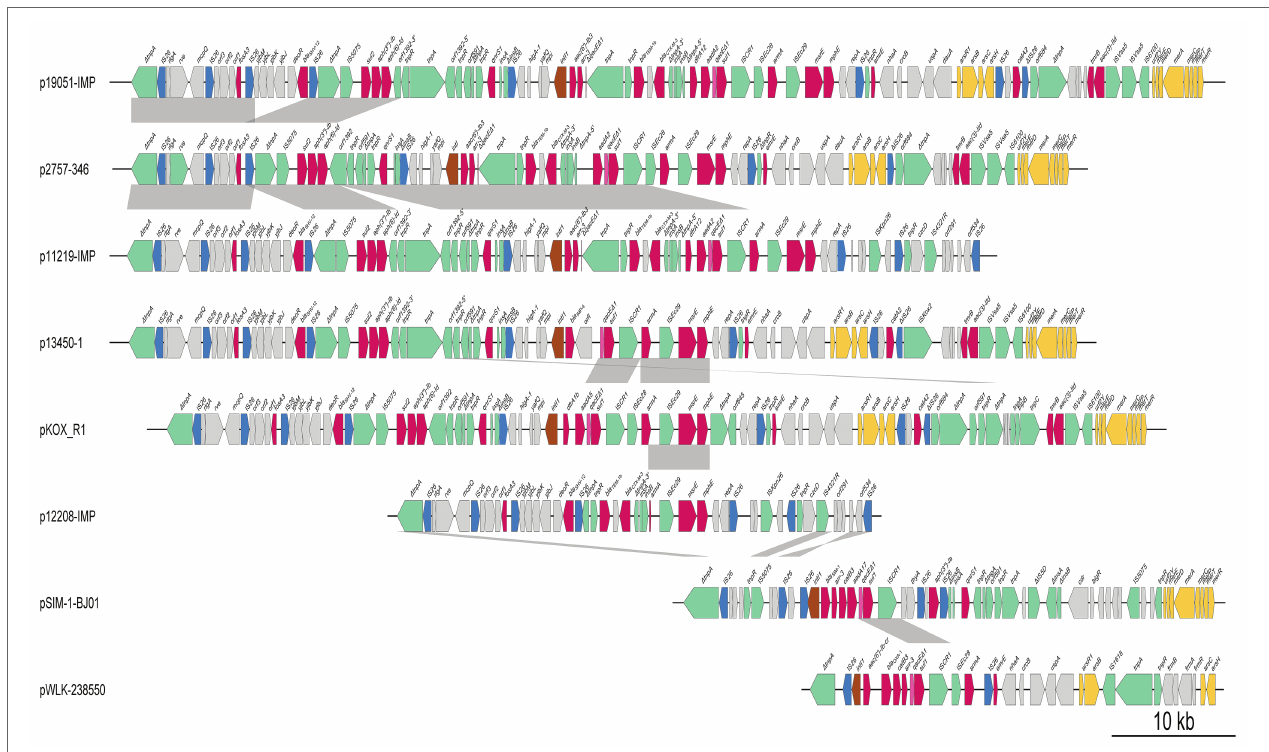
FIGURE 5 | Comparative genomic analysis of antibiotic resistance island B (ARI-B). Mobile elements are shown by green, brown, and blue arrows, respectively. The red arrows indicate antibiotic resistance genes, the pink arrows denote biocide resistance genes, and the gray arrows represent genes of other functions. The shading indicates 100% nucleotide sequence identity.